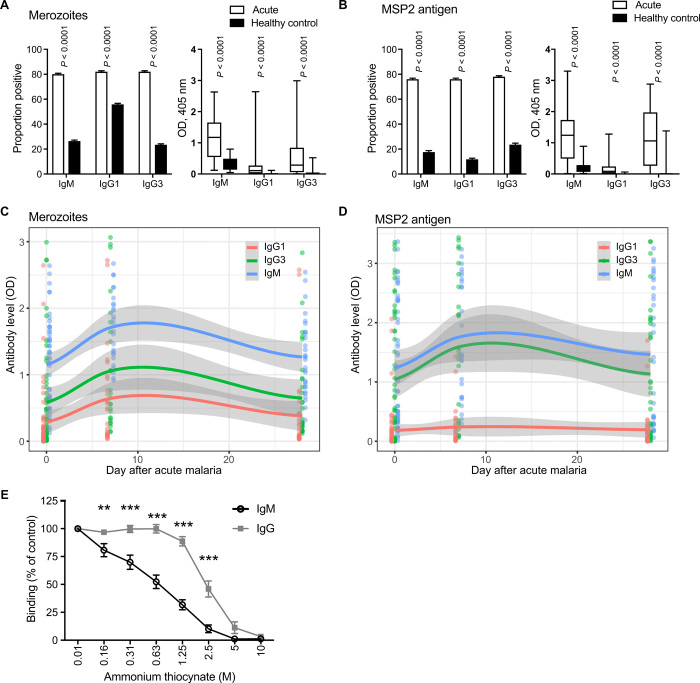
Induction and waning kinetics of merozoite-specific IgM during naturally acquired P. falciparum malaria.(A and B) IgM, IgG1, and IgG3 binding to intact merozoites (A) and recombinant MSP2 (B) was assessed among individuals with clinical malaria (n = 50) and uninfected endemic community controls (n = 30) in individuals in Sabah, Malaysian Borneo. Antibody reactivity is shown as seroprevalence and media [plus interquartile range (+IQR)] OD. Seroprevalence (left) was calculated using a cutoff defined as the mean OD + 3SDs of unexposed Australian naïve controls. (C and D) IgM, IgG1, and IgG3 binding to intact merozoites (C) and recombinant MSP2 (D) was assessed in patients with clinical malaria in Sabah, Malaysian Borneo, and at 7 (n = 26) and 28 days (n = 32) after anti-malarial treatment. Solid lines and gray area are generated from LOWESS smooth calculations in R software. Raw data are indicated as points. (E) Affinity of IgM and IgG to MSP2 was assessed by the dissociation of antibodies using increasing concentrations of ammonium thiocynate. Data are means ± SEM of eight individuals tested in two assays in duplicate, expressed as the percentage of OD in PBS. P values indicate Sidak’s multiple comparison test of IgM versus IgG from two-way ANOVA, taking into account repeat measures for each individual (**P < 0.01 and ***P < 0.001).